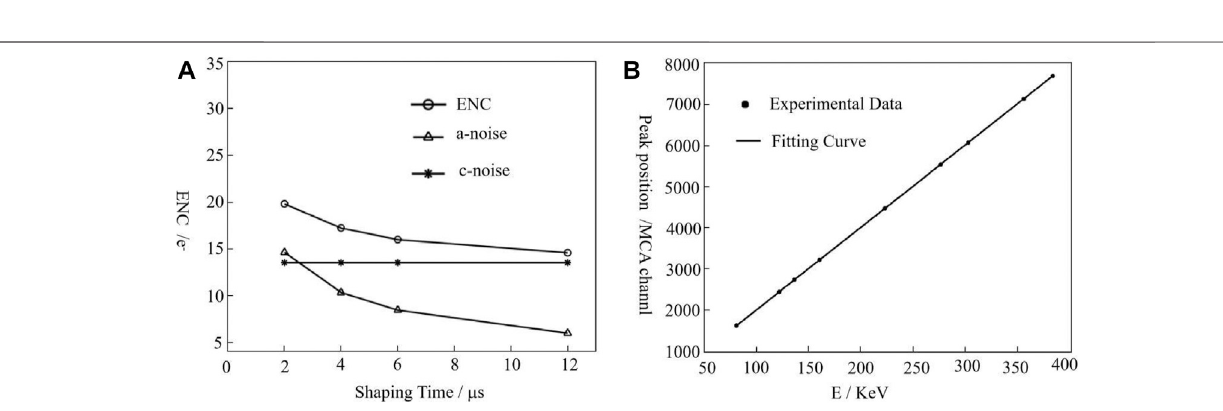
Frontiers in Materials |